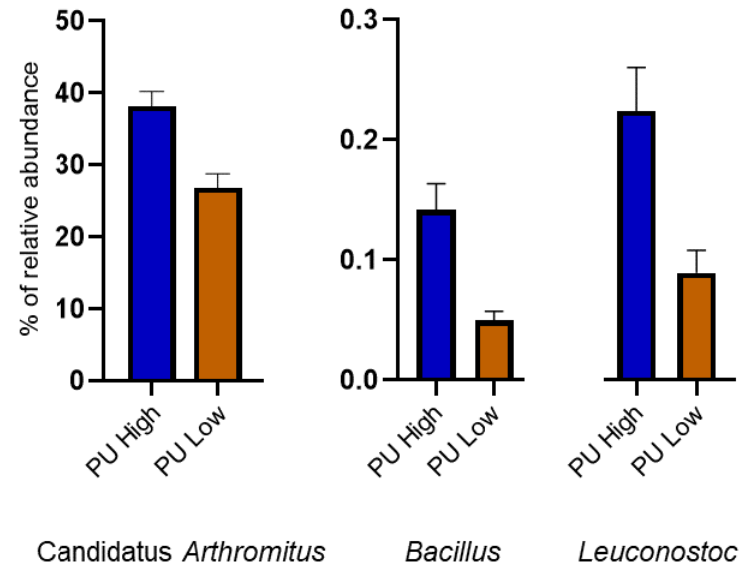
Figure 1. Relative abundance of the genera influenced by the P utilization (PU) in the high and low groups.